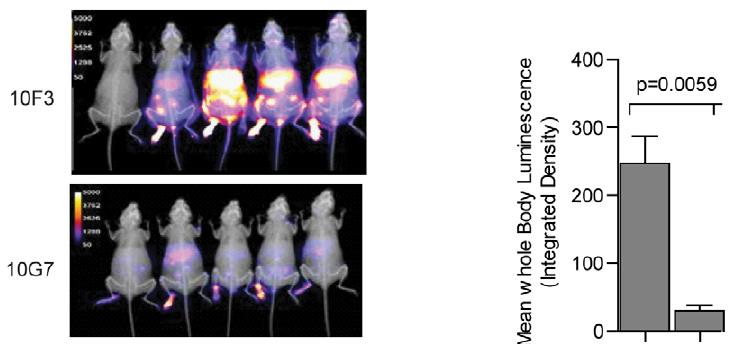
Figure 7. Treatment with blocking 10G7 but not with non-blocking 10F3 decreases overall virus loads as determined by whole body imaging. BALB/c mice were infected with 300 pfu of ECTV-Luc in the footpad, at 5 dpi, the mice were treated with indicated mAbs IP and imaged 2 dpt for light emission using a Carestream In vivo instrument for bioluminescence detection (left) The mouse on the top-left is an uninfected control. The bar graph (right) shows the mean 6 SEM quantitative luminescence intensity of the two groups. The experiment is representative of two similar experiments.